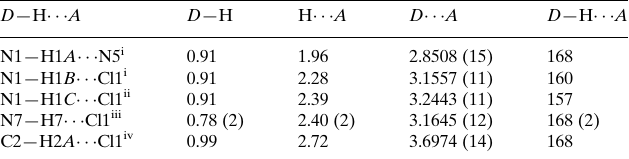
Hydrogen-bond geometry (A˚ , (cid:4)